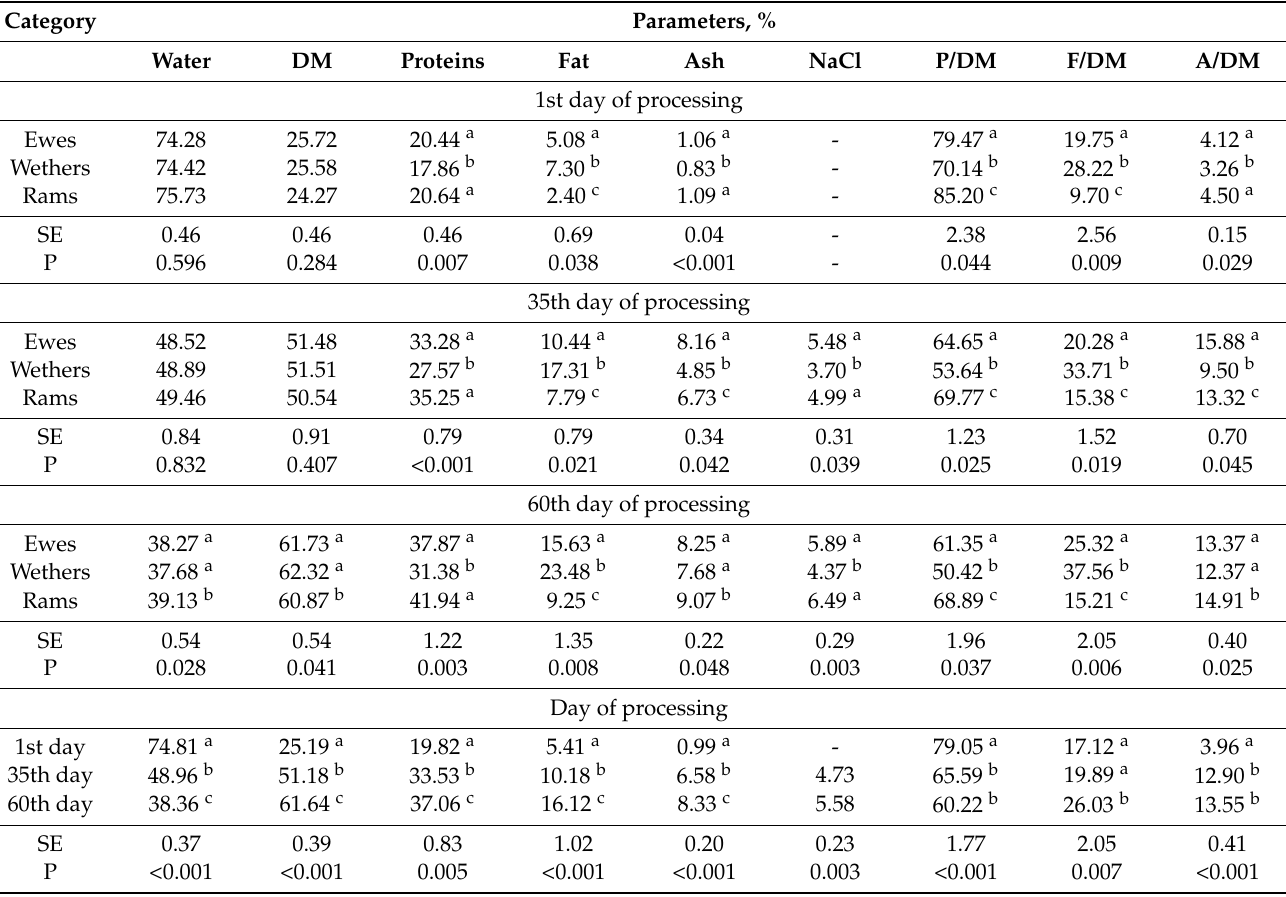
Table 1. Proximate chemical composition of different categories of raw mutton and kaštradina in different processing times, %. Category